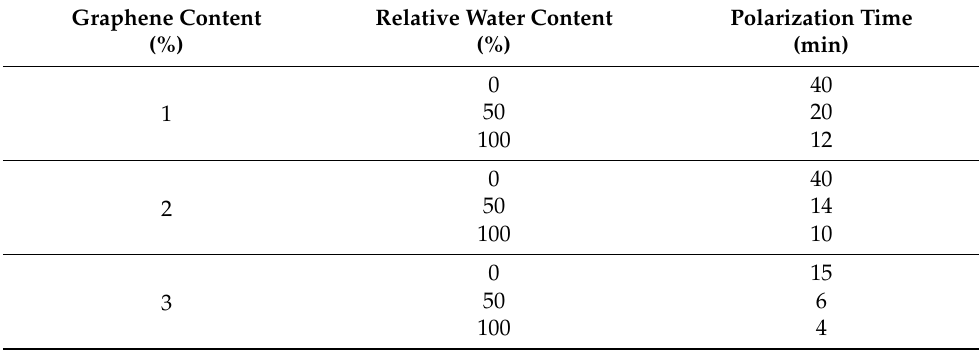
Figure 9. Influence of relative water content on polarization effect of specimens incorporating different graphene contents after 50 freeze–thaw cycles: ( a ) 1%; ( b ) 2%; ( c ) 3%. Table 7. Polarization time of specimens incorporating different graphene contents after freeze–thaw cycles at different relative water contents.